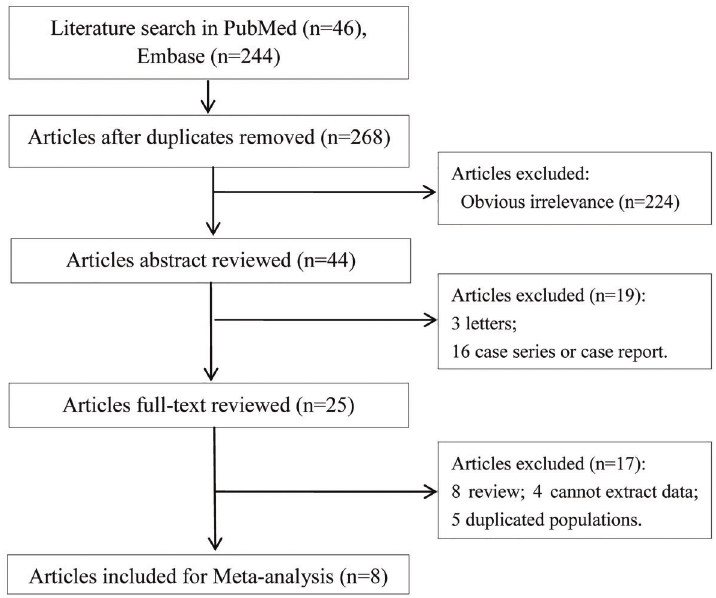
Figure 1. Flow chart of literature search and study